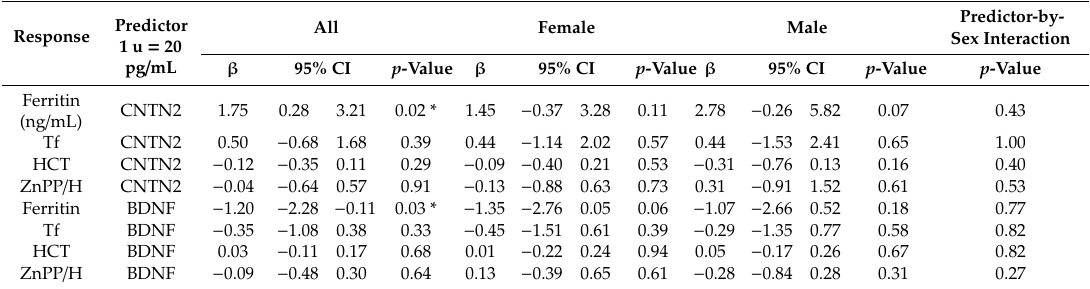
Table 2. Contactin-2 (CNTN2) and brain-derived neurotrophic factor (BDNF) as predictors of iron-related markers.